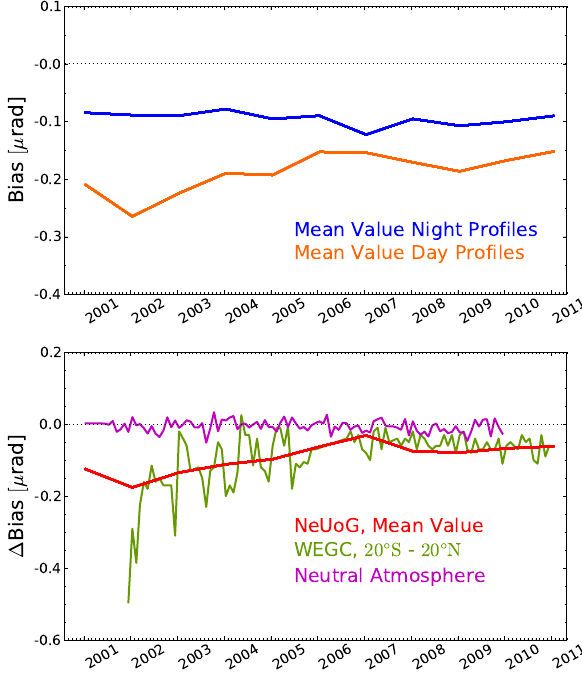
Fig. 6. Top panel: mean daytime (orange line) and nighttime (blue line) bending angle bias of the simulated profiles. Bottom panel: mean bending angle bias difference ( ∆ Bias) of the simulated profiles (red line), the WEGC processed satellite data (green line) and the neutral atmosphere simulation time series at latitude and longitude 0 ◦ (magenta line). Fig. 5. Comparison of CHAMP and COSMIC bending angle bias time series based on WEGC processing. The top panel shows CHAMP and COSMIC day time and night time bias characteristics, the bottom panel displays the bias difference ∆ Bias in the latitude zone 20 ◦ S and 20 ◦ N .